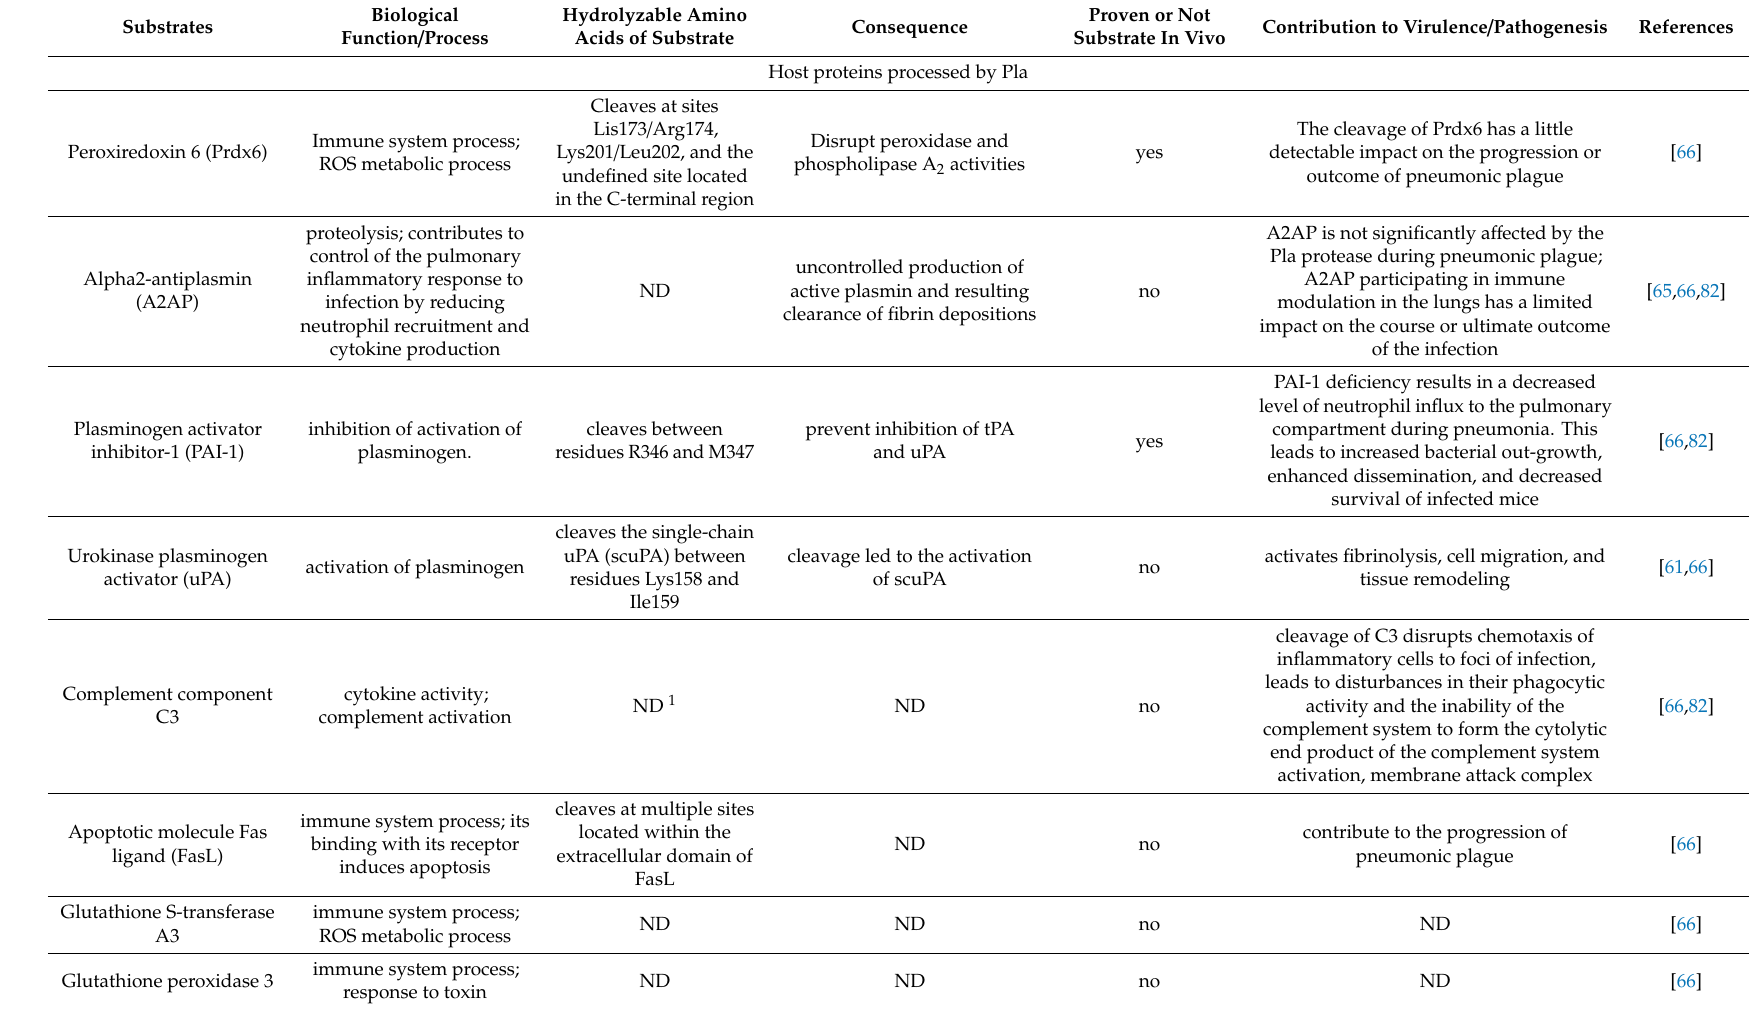
Table 1. Pla interactions with di ff erent